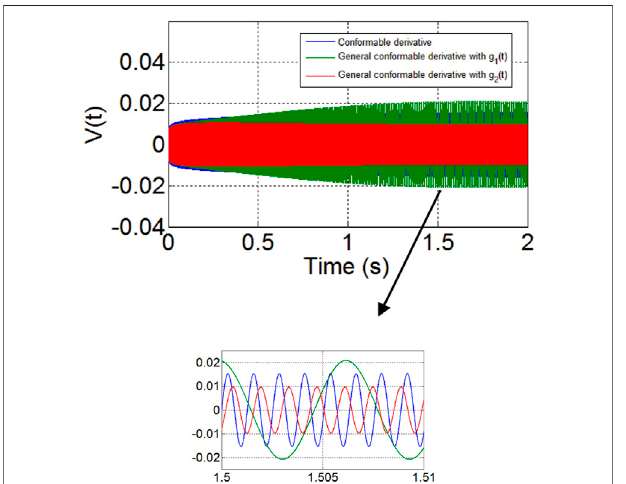
FIGURE 12 | Evolution of V ( t ) with α (cid:2) 0 . 8.